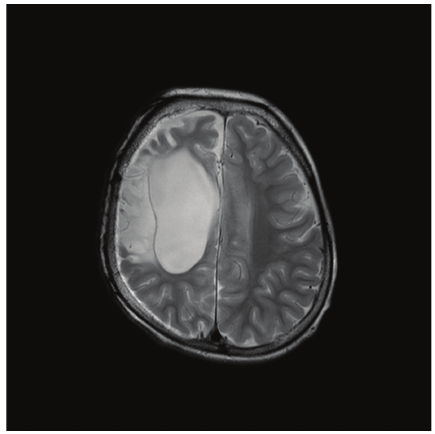
Figure 7: T2W Axial MRI image of a 5-year-old boy who presented with intractable epilepsy secondary to postencephalitic sequelae (PES) causing damage to the right